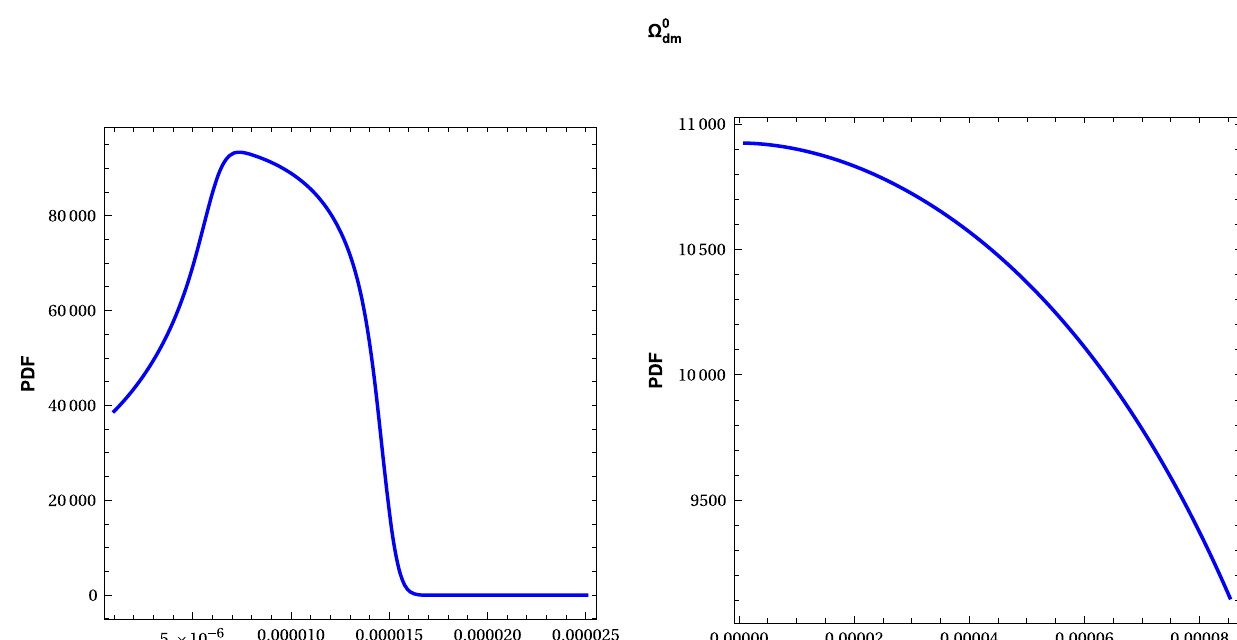
Fig. 3 The first CMB peak one-dimensional probability distribution, after marginalizing on the other variables